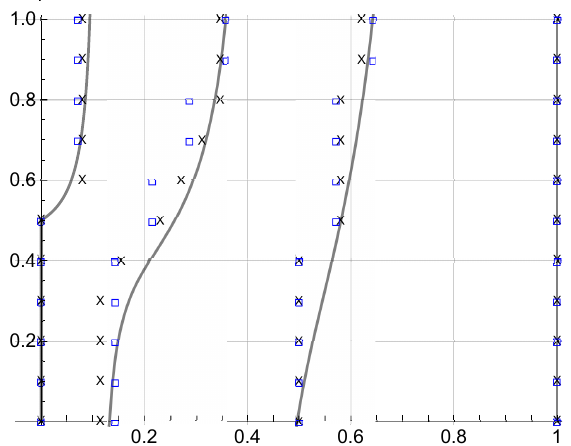
Figure 12. Coupling between the third and fourth modes. = model solution; (cid:3) = FEM simulations; × = experimental results.